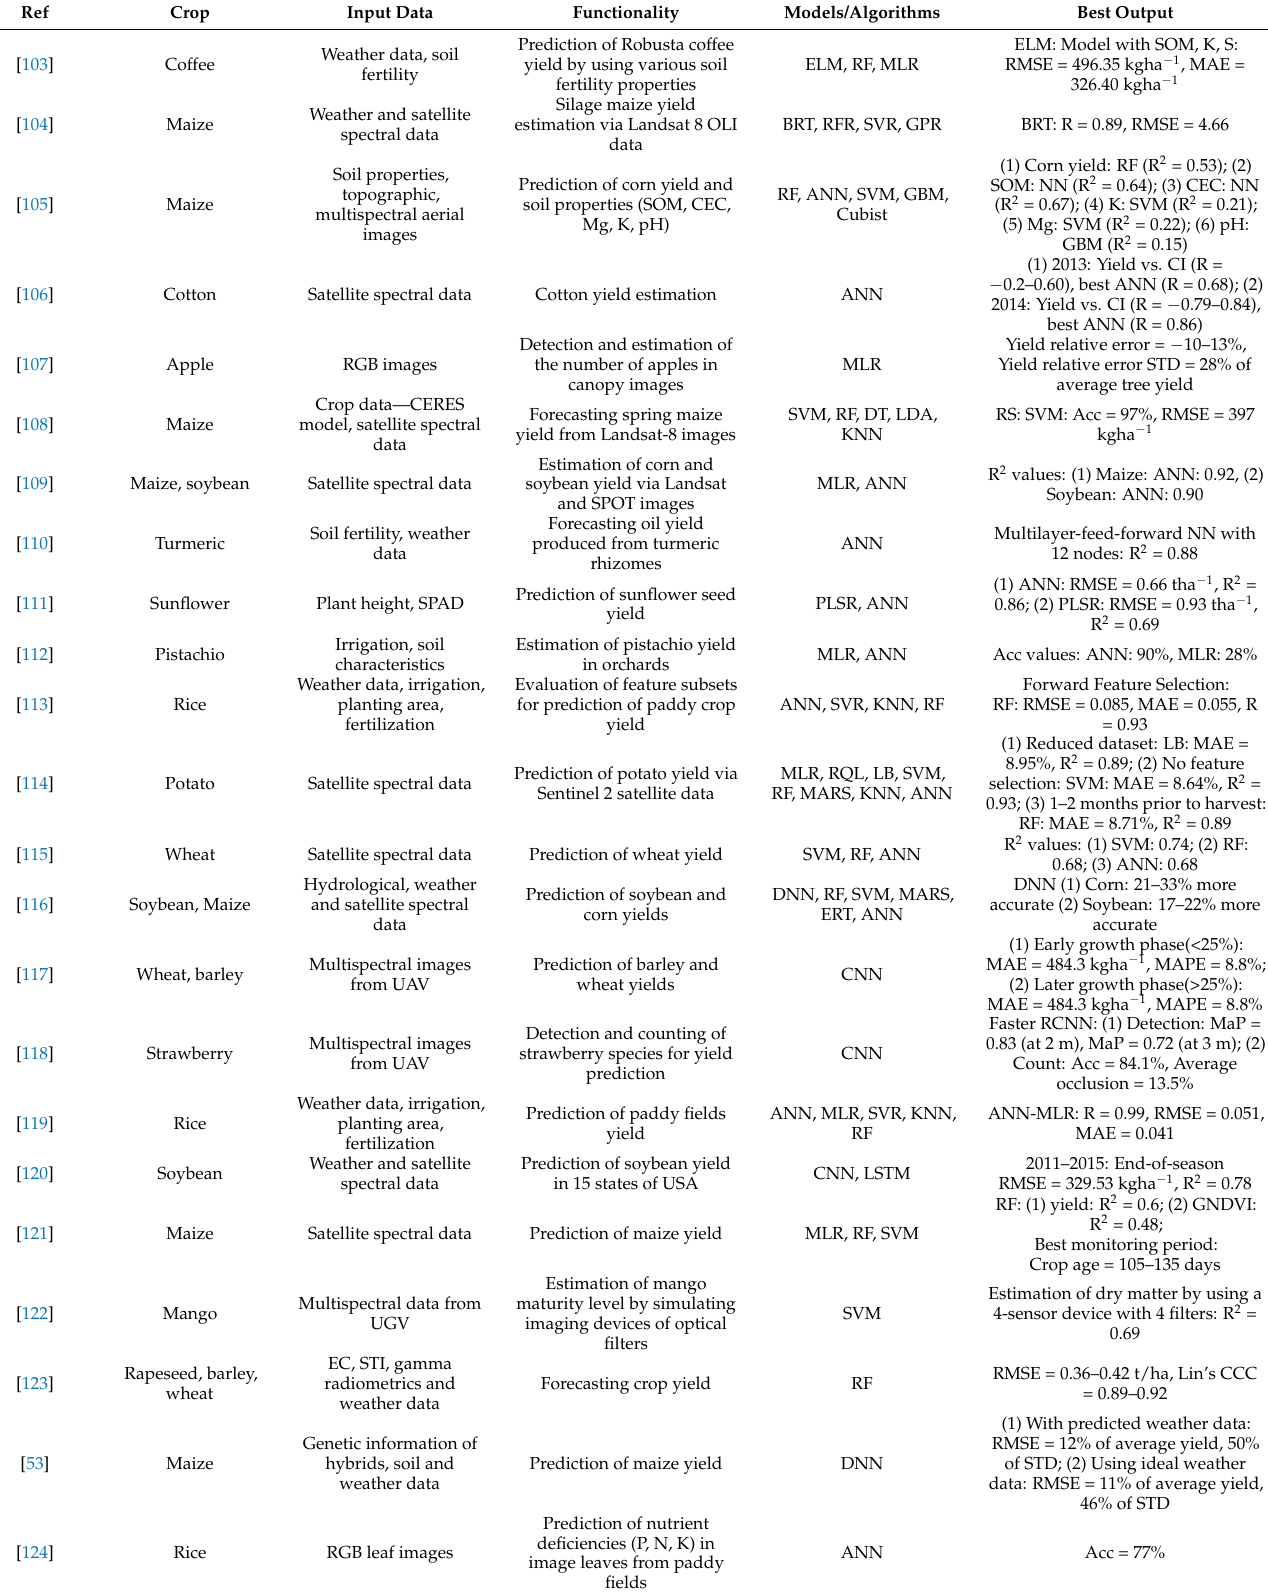
Table A1. Crop Management: Yield